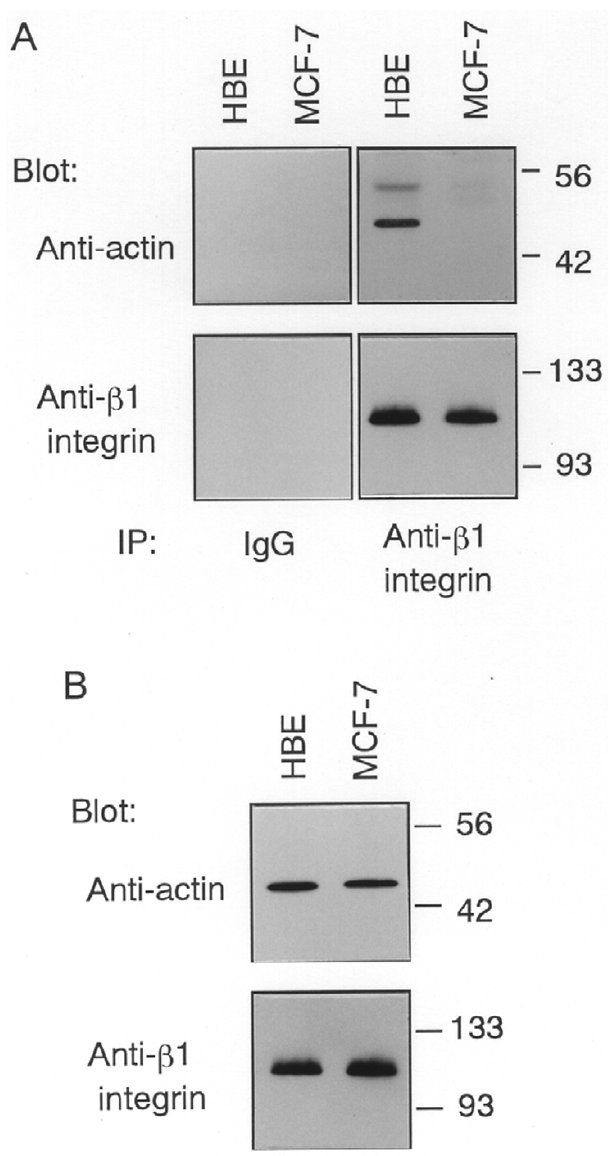
Figure 1 Coprecipitation of actin with β 1 integrin in HBE cells and not in MCF-7 cells. (A) Integrin β 1 was immunopre- cipitated (IP) with the anti- β 1 integrin antibody or control IgG from HBE or MCF-7 cells which were quiescent and adherent to collagen IV. The immunoprecipitates were immunoblotted with anti-actin or anti-integrin β 1 mono- clonal antibody. Molecular size markers are indicated at right in kDa. (B) Whole cell lysates were prepared from HBE or MCF-7 cells which were quiescent and adherent to collagen IV, and equal amounts (5 µ g protein) of the lysates were resolved by SDS-PAGE and blotted. The blots were probed with anti-actin or anti-integrin β 1 monoclonal antibody. Molecular size markers are indicated at right in